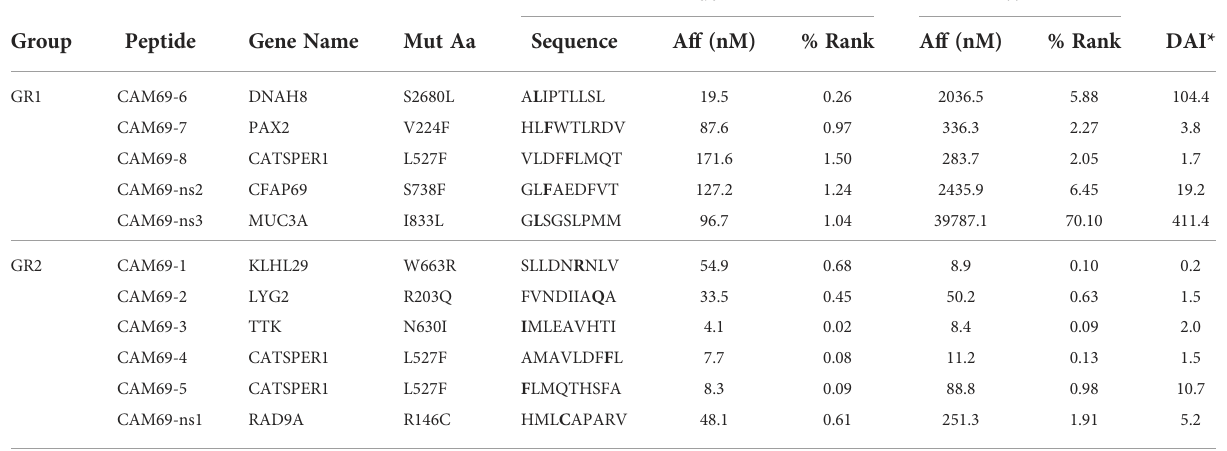
TABLE 2 HLA-A*02:01-restricted neoAgs in patient CAM69. Mut WT Group Peptide Gene Name Mut Aa Sequence